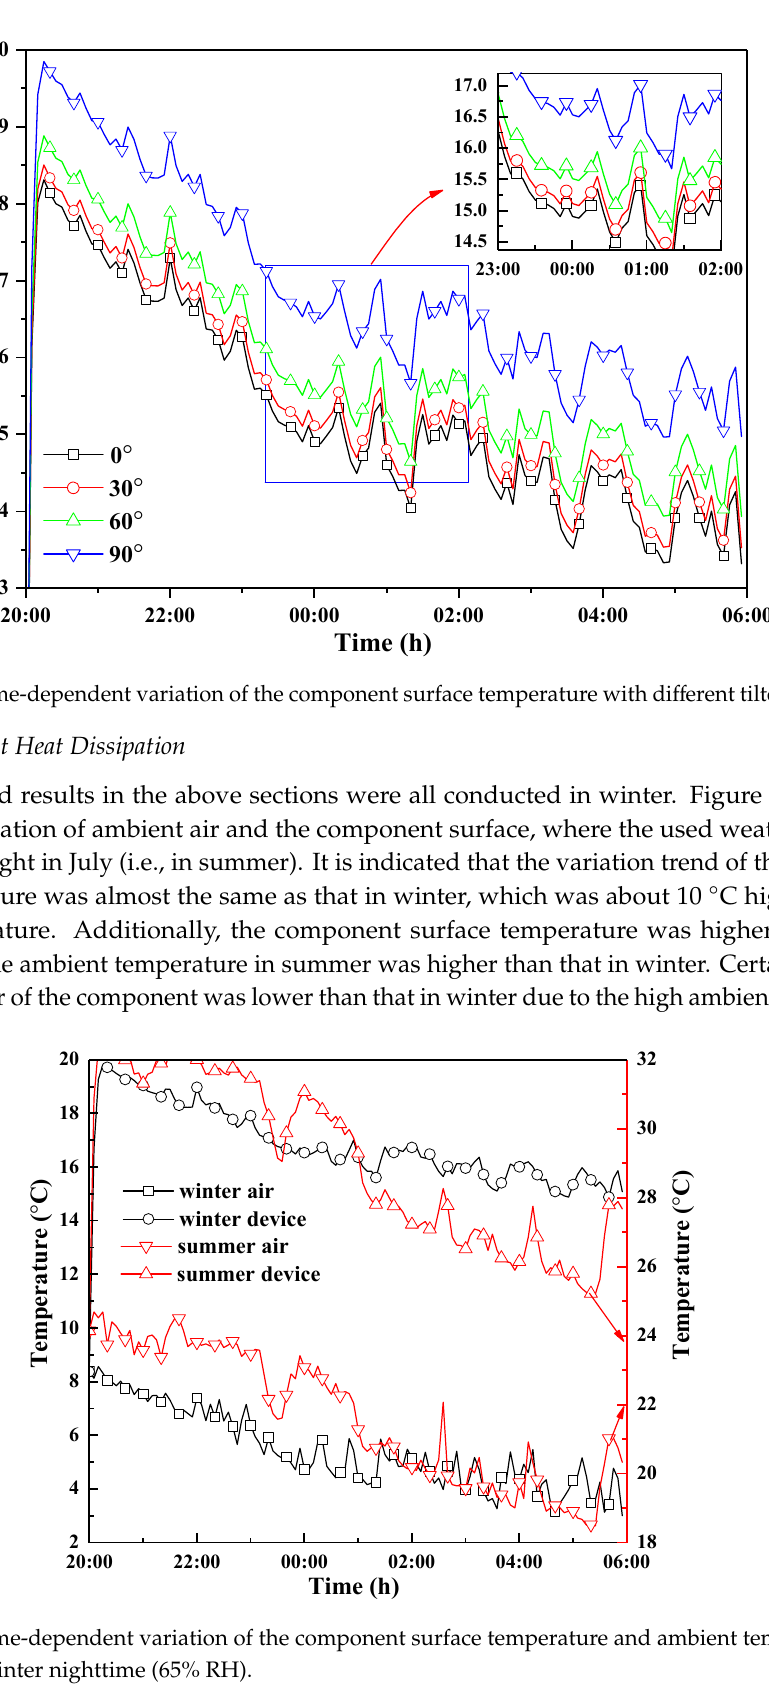
Figure 22. Time-dependent variation of the component surface temperature and ambient temperature in summer/winter nighttime (65% RH).